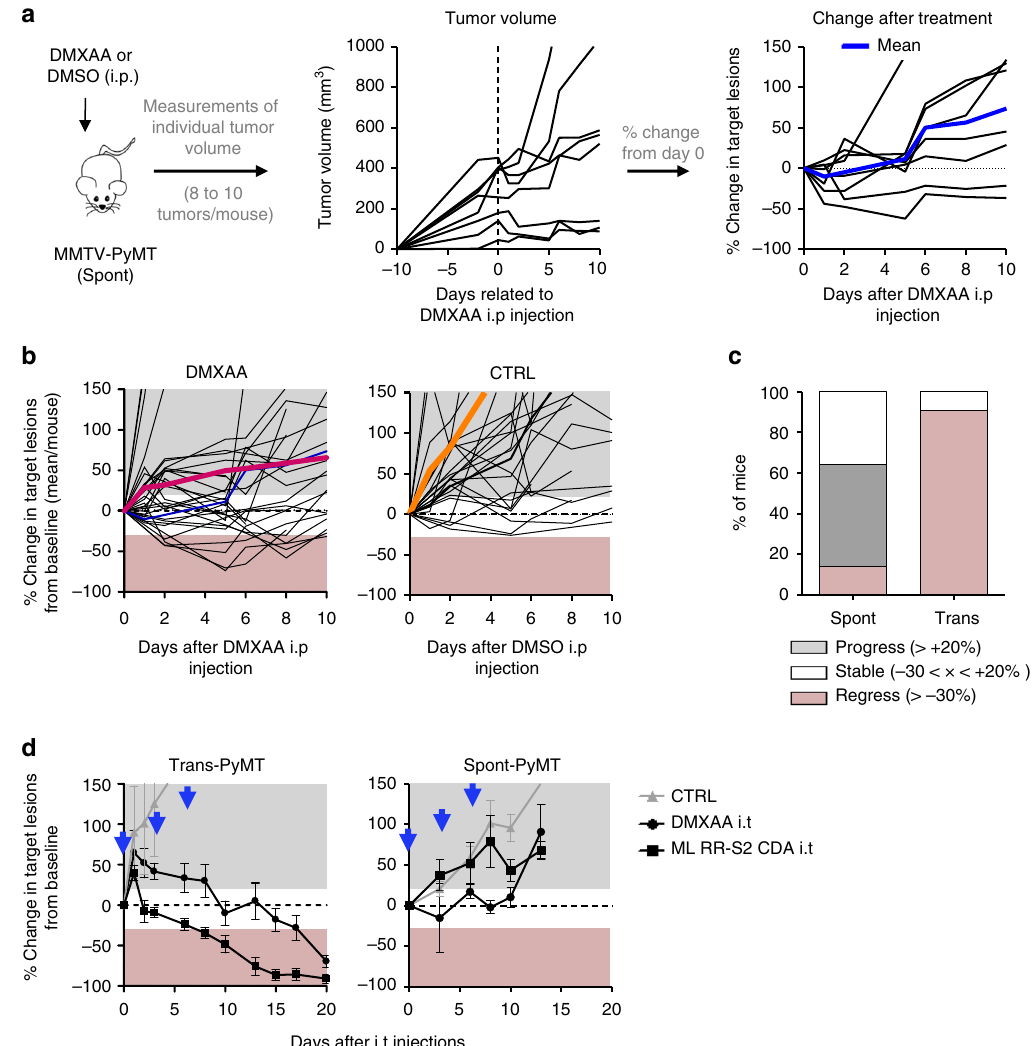
Fig. 1 DMXAA does not induce a systematic regression of Spont-PyMT tumors. a Spont-PyMT mice were treated at day 0 with one i.p. injection of DMXAA or DMSO as a control. For each treated mouse, the changes in tumor size from baseline (d0) was calculated at each time point and expressed relative to the size at d0. The graphs in ( a ) provide an example of measurements obtained in one mouse treated with DMXAA i.p., with one curve per tumor. The average curve of all tumors of this mouse is shown in blue. The mouse clipart was created by N.B. b Each black curve corresponds to one mouse, and is calculated as the average relative tumor change for this mouse (as shown in a ). The average curves for all the animals of a cohort are shown in red (DMXAA) or orange (CTRL). Overall progression (gray area) or regression (pink area) of tumor burden are indicated. Spont-PyMT mice: n = 30 (DMXAA), n = 25 (CTRL), from nine independent experiments. c The proportion of mice with, on average, regressing, stabilized or progressing tumors, are represented for these Spont-PyMT mice, in comparison with Trans-PyMT mice. Spont-PyMT mice: n = 30; Trans-PyMT mice: n = 26, from 9 to 10 independent experiments, respectively. d Intratumoral injection of DMXAA or ML RR-S2 CDA-induced tumor regression in Trans-PyMT mice, but not in Spont-PyMT mice. Trans- and Spont-PyMT mice were injected i.t. with DMXAA (1 × 500 µ g, day 0) or ML RR-S2 (3 × 50 µ g, at days 0, 3, and 6) or with HBSS i.t. as controls. Blue arrows: days of injections. The average fold change in tumor volume compared with baseline (day 0) is shown for each treated group. ML RR-S2 group (Spont-PyMT mice n = 4; Trans-PyMT mice n = 10), DMXAA (Spont-PyMT mice n = 3; Trans-PyMT mice n = 10), and HBSS/ DMSO (Spont-PyMT mice n = 4; Trans-PyMT mice n = 6). The data are from three independent experiments for both tumor models. Source data